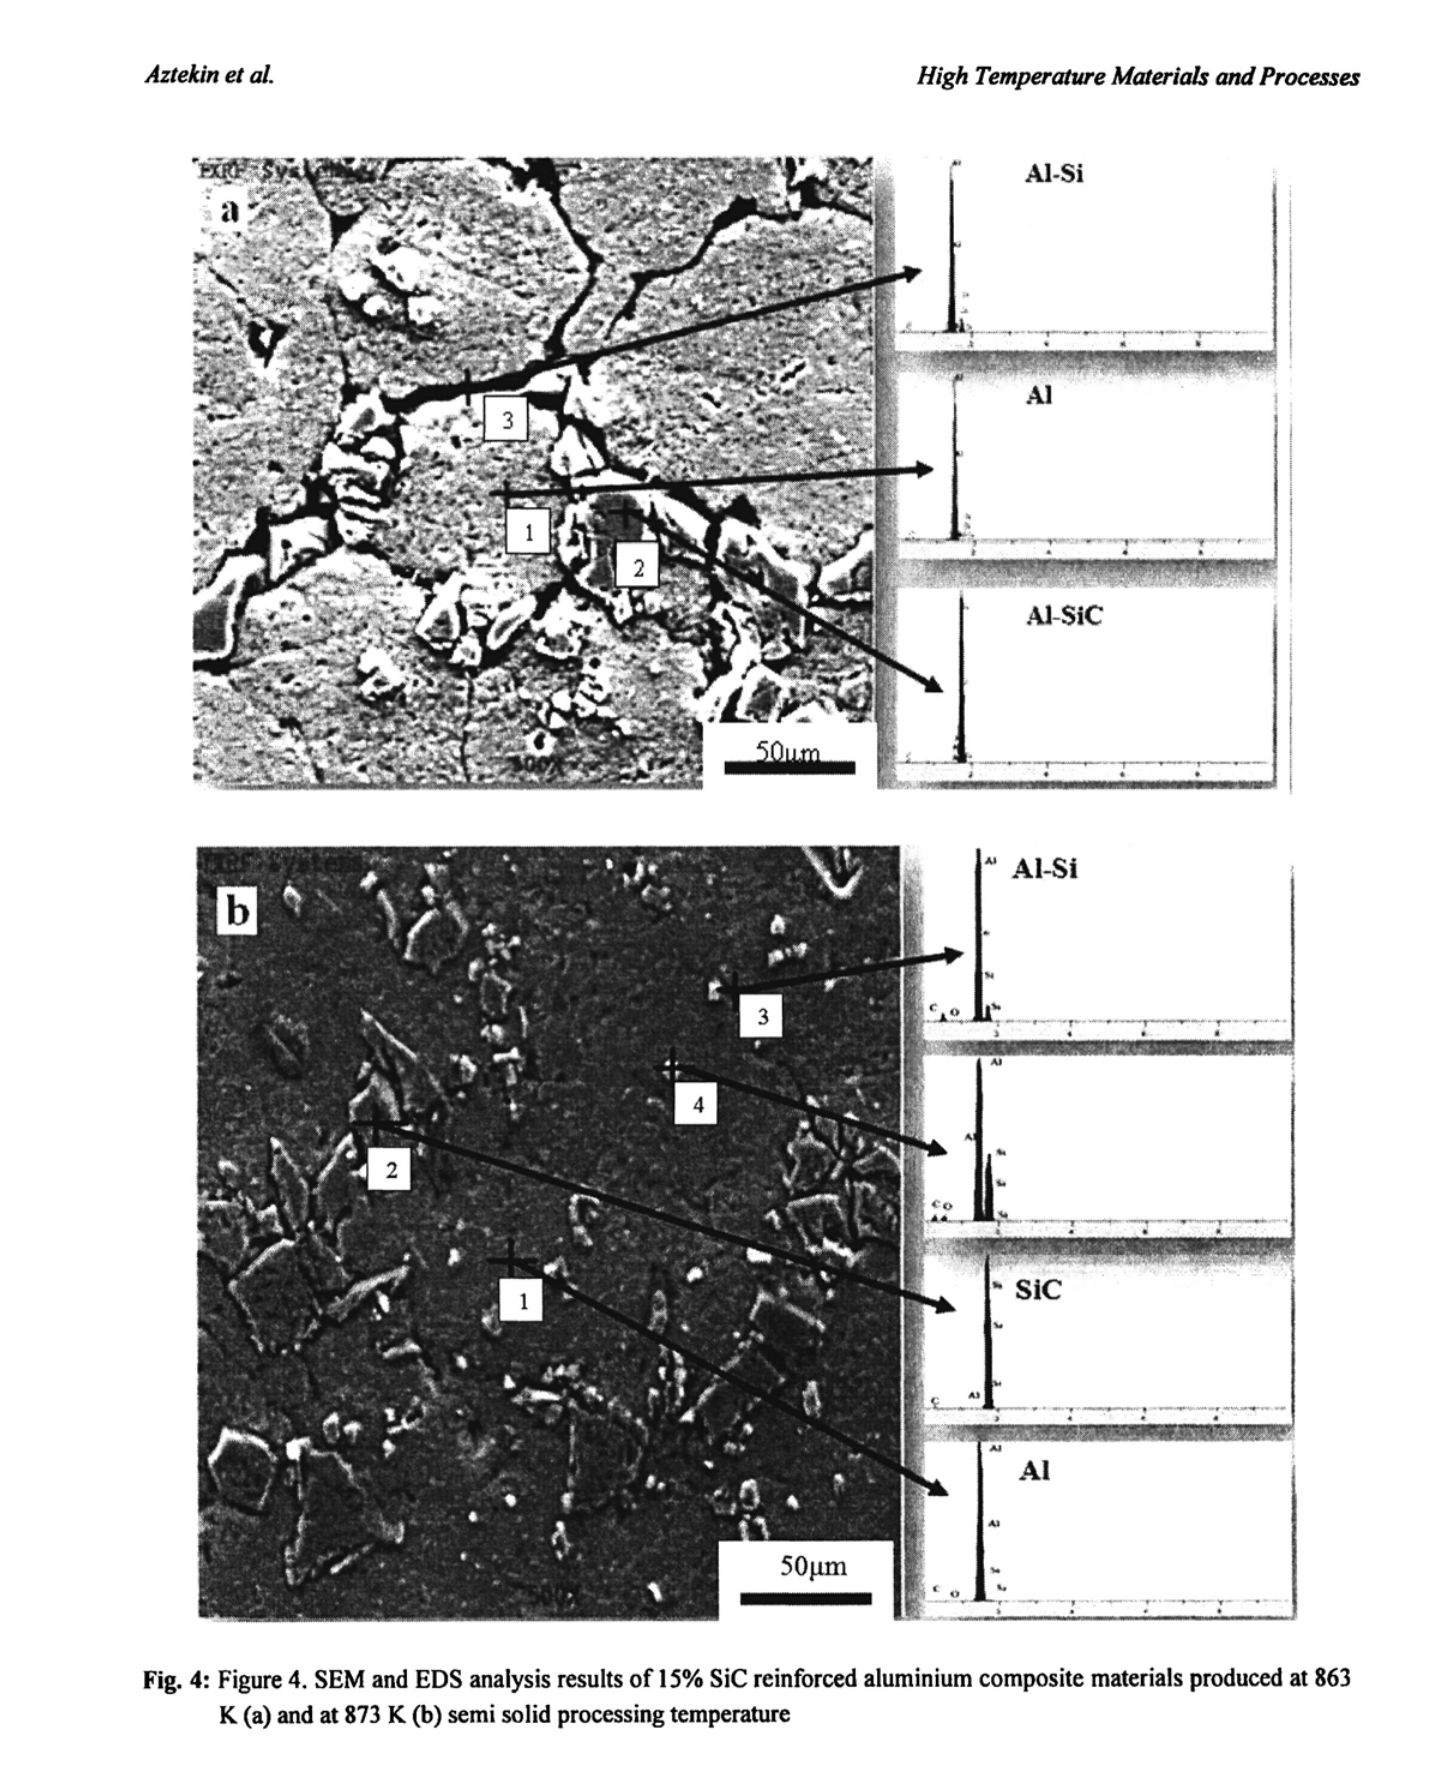
Fig. 4: Figure 4. SEM and EDS analysis results of 15% SiC reinforced aluminium composite materials produced at 863 K (a) and at 873 K (b) semi solid processing temperature